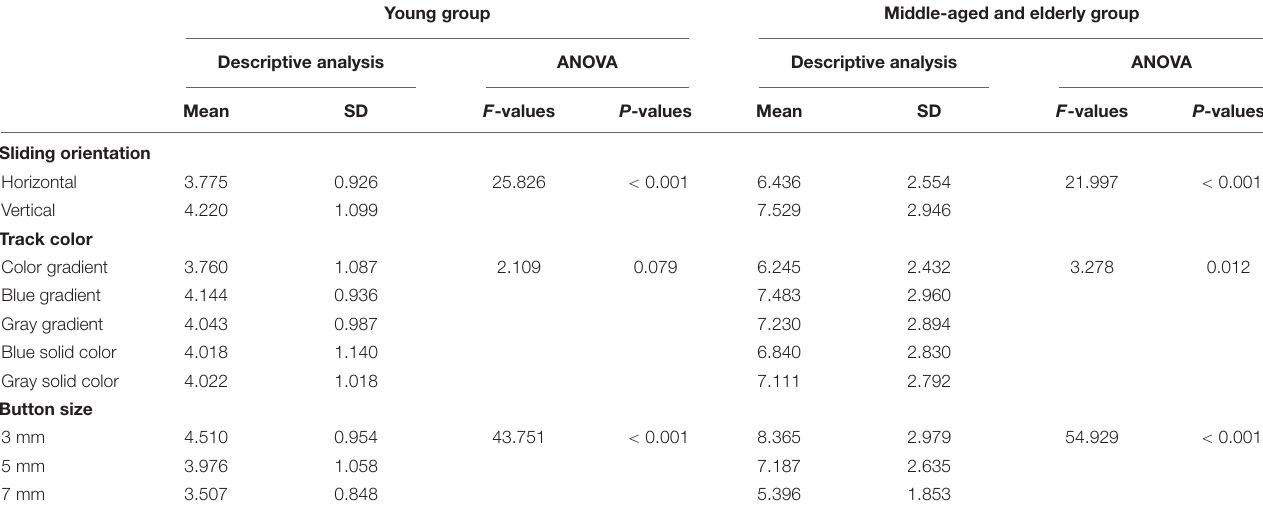
TABLE 3 | Main effects of sliding orientation, track color, and button size on task completion time